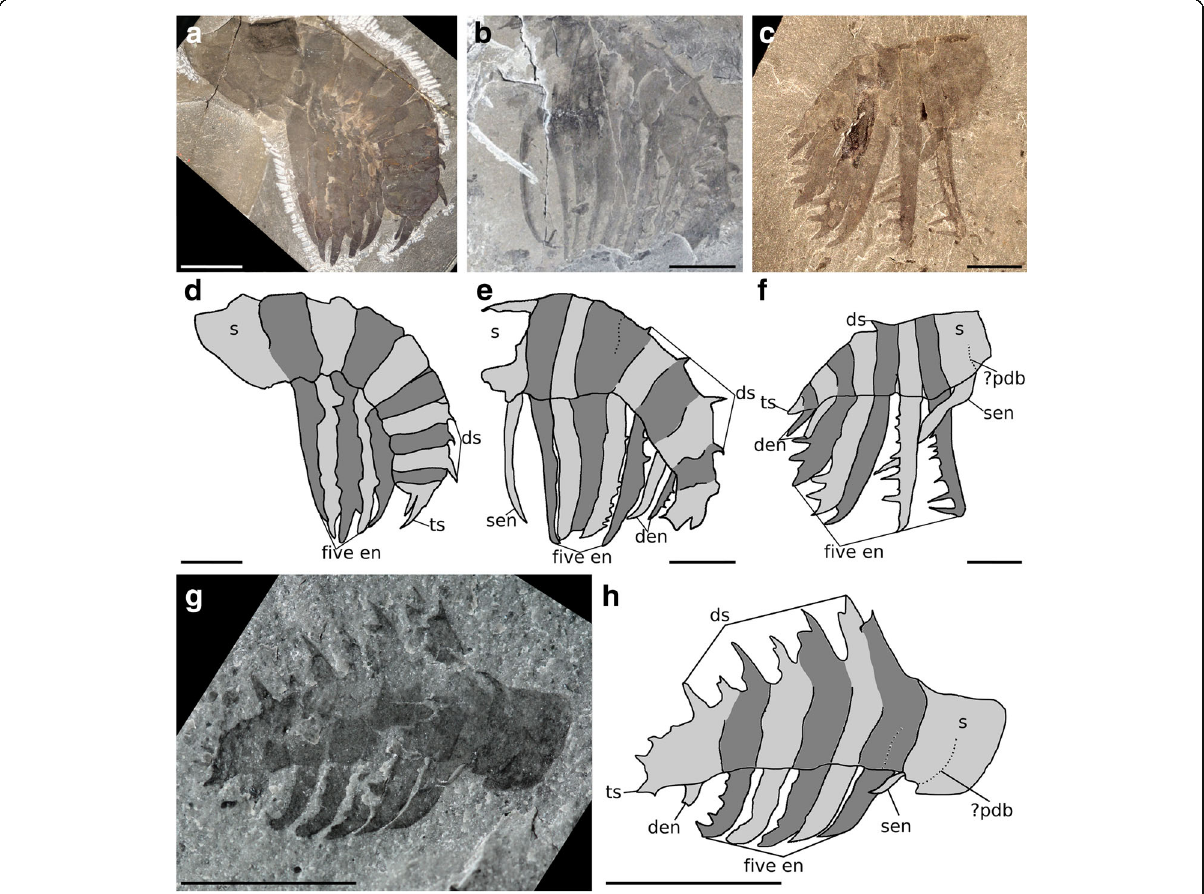
Fig. 2 Hurdiid frontal appendages bearing auxiliary spines. a and d Peytoia nathorsti from the Burgess Shale, British Columbia, Canada, USNM 240984. b and e ? Peytoia from the Burgess Shale, British Columbia, Canada, ROM 59508 ( ?Laggania of [22]). c and f . Hurdia from the Burgess Shale, British Columbia, Canada, ROM 60048. g and h Stanleycaris hirpex from Stephen Formation, British Columbia, Canada, ROM 59975. Abbreviations: den, distal endites; ds, dorsal spines; five en, five subequal endites on first five podomeres of distal articulated region; pdb, podomere boundary; s, shaft; sen, shaft endite. Scale bars = 10